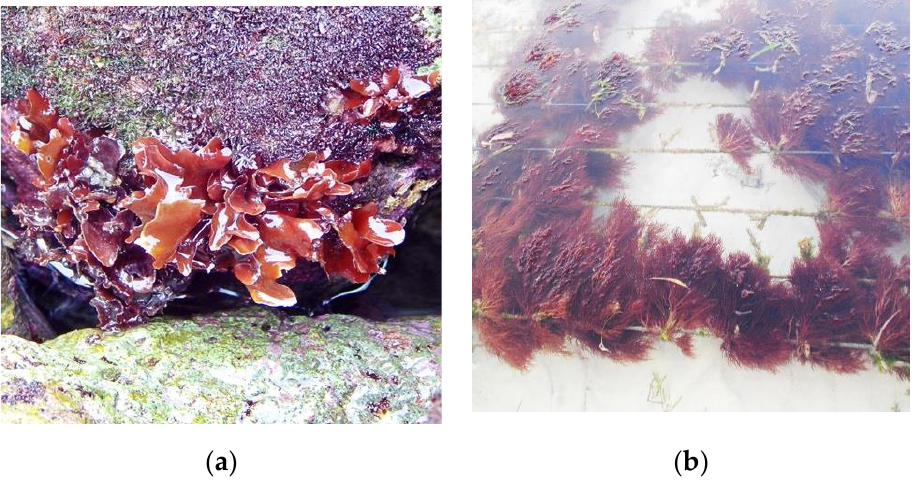
Figure 1. Red seaweeds grow on ( a ) rocky substrate and ( b ) float in water.